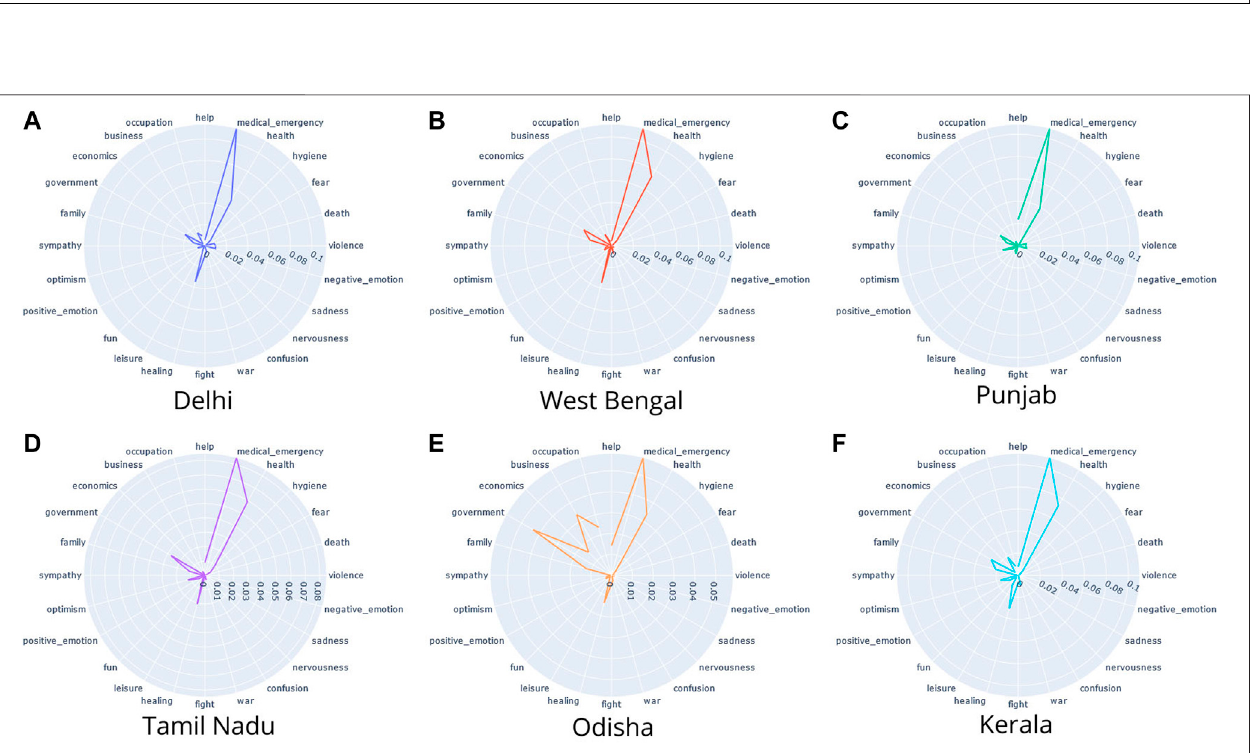
FIGURE 6 | Empath analysis of government bulletins related to COVID-19 in India.